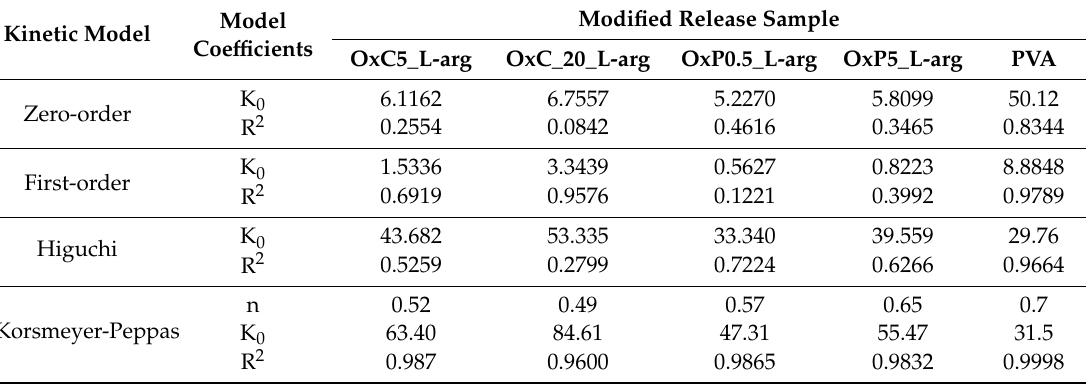
Table 2. Results of curve fitting of the in vitro L-arginine release profile from hydrogels based on oxidized natural polysaccharides and